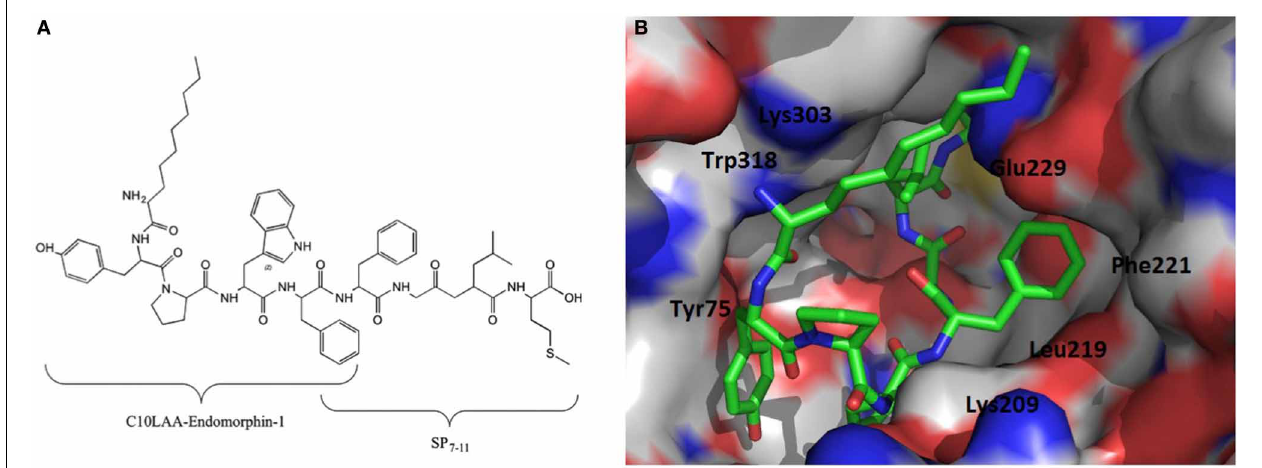
FIGURE 5 | In vitro biological analyses revealed that the C10LAA-modified analog conjugated with SP 7 − 11 fragment was the most promising derivative. (A) Structure of the compounds. (B) Surface view of the active site of the MOP receptor for the highest docking score